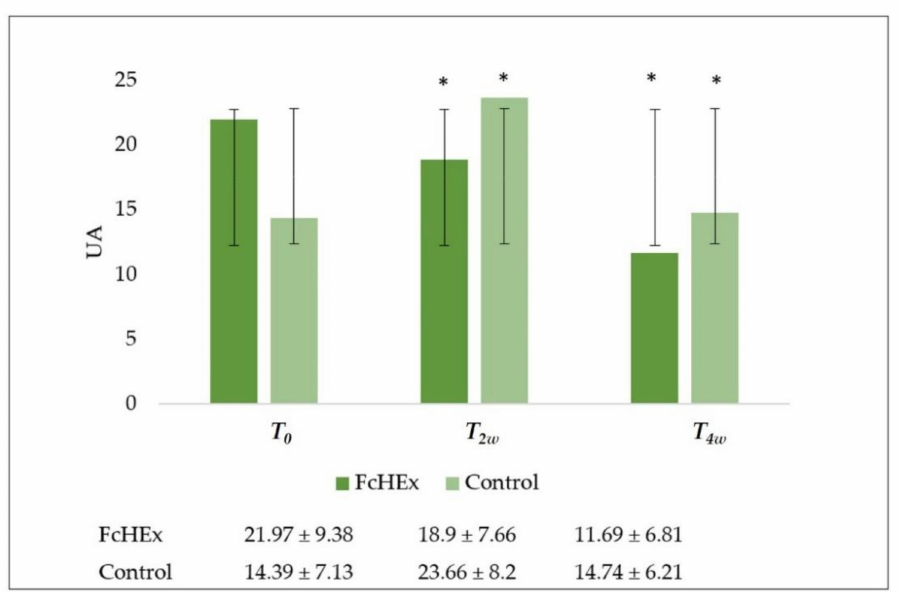
Figure 11. Skin exfoliation evaluation. The corneum exfoliation trend value at time T 0 (before the application), T 2w (after two weeks—acute stress), and T 4w (after four weeks—recovery effect). All the measurements for T 2w vs. T 0 and T 4w vs. T 0 for the FcHEx and the control were statistically significant. The asterisks indicate statistically significant values (* p -value was between 0.01 and